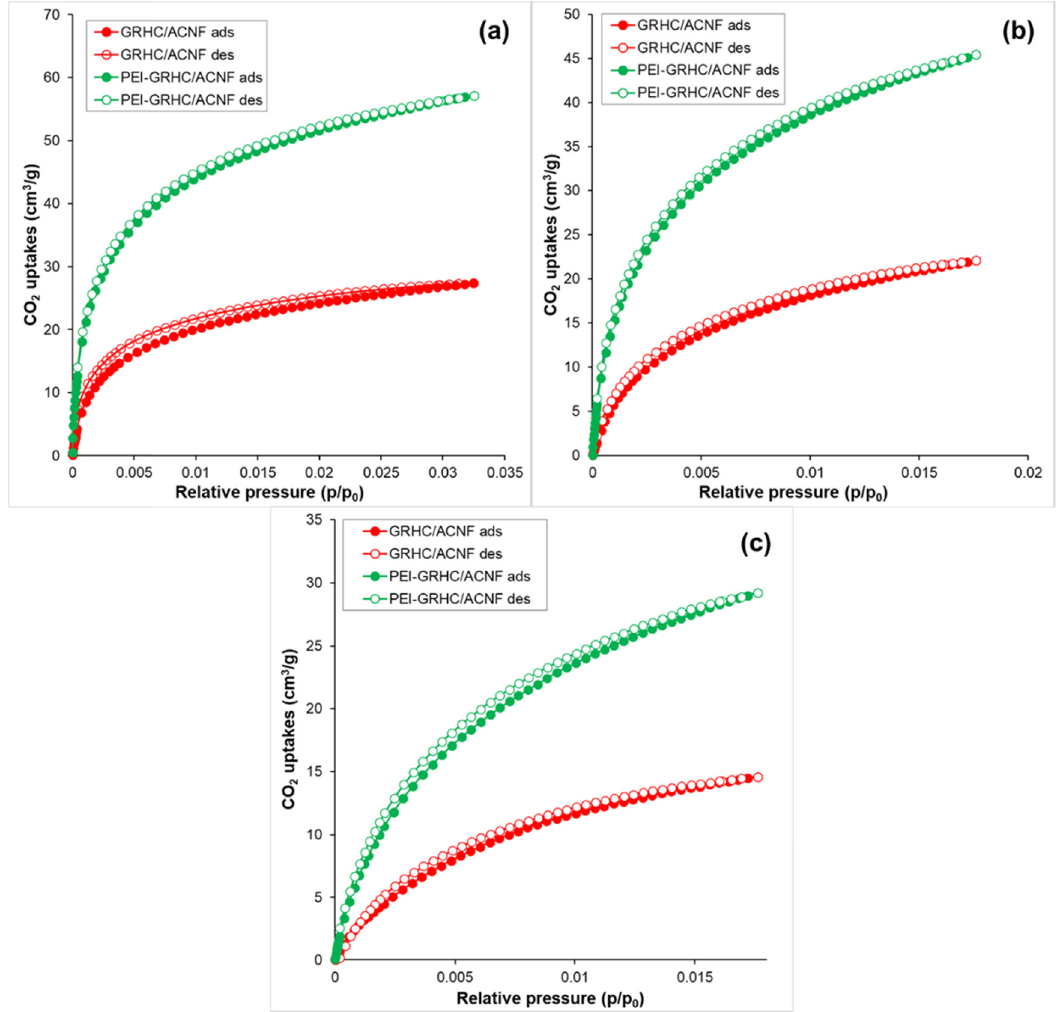
Figure 10: CO 2 adsorption/desorption on PEI - impregnated and nonimpregnated GRHC/ACNFs at di ff erent temperatures ( a ) 0°C; ( b ) 25°C; and ( c ) 50°C under atmospheric